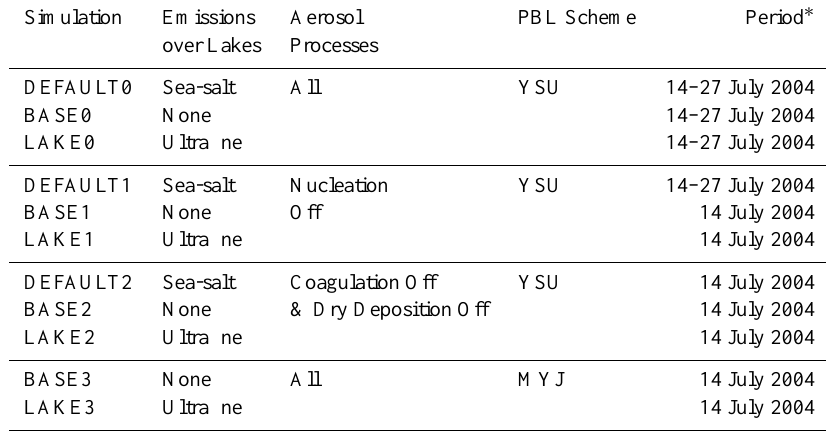
Table 1. Summary of WRF-Chem simulations performed.